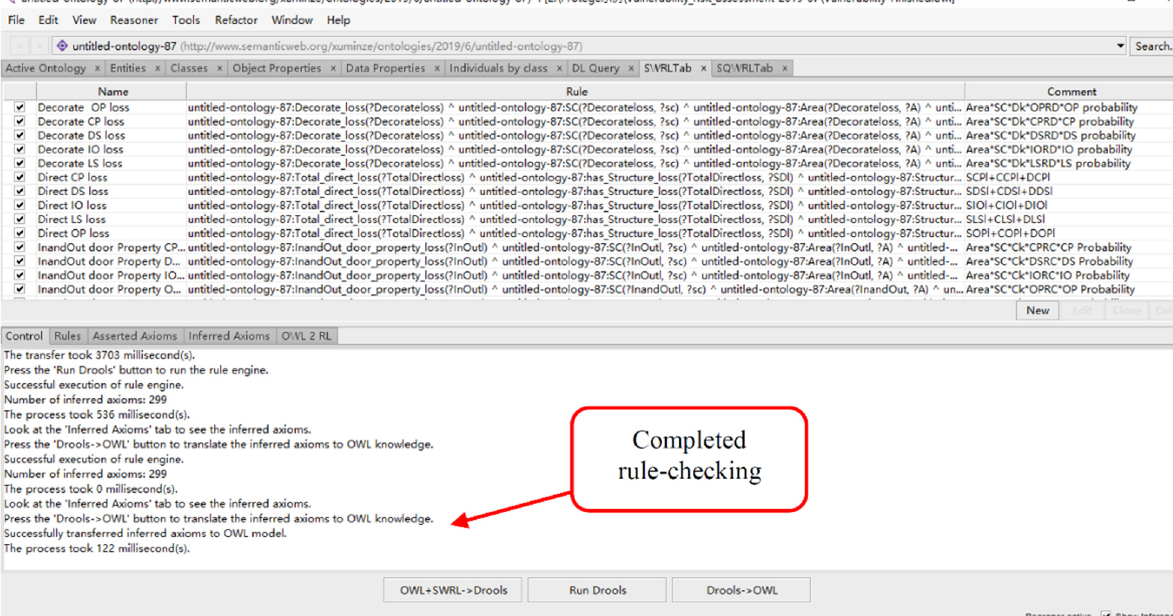
Figure 8. Rule-checking.